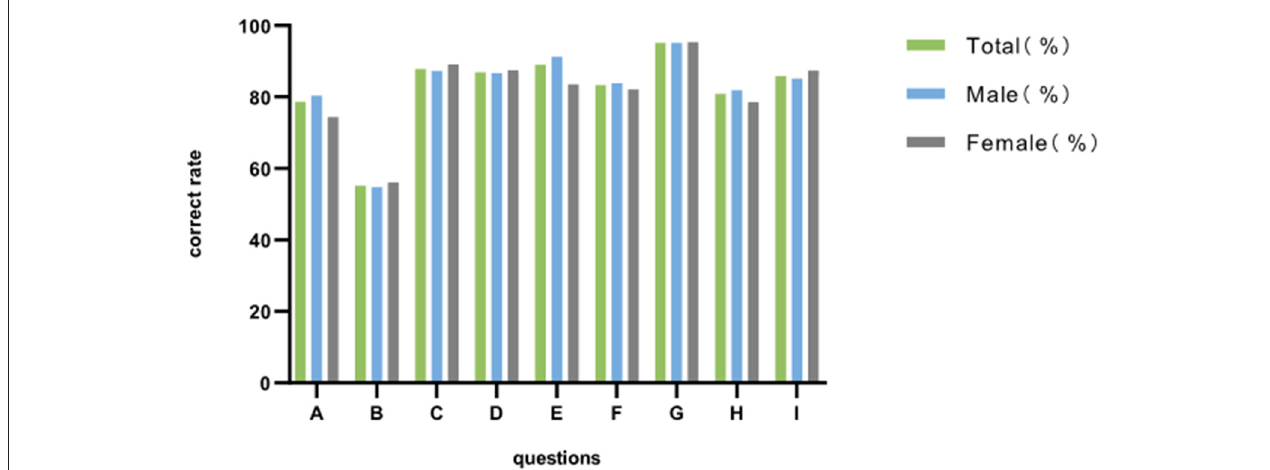
FIGURE 2 | The correct rate of participants’ HIV health education knowledge by gender. (A) AIDS is an incurable disease. (B) The incidence of AIDS among young Chinese students is increasing, and the main mode of.transmission is male homosexual behavior. (C) It can be judged by appearance that a person is infected with AIDS. (D) AIDS may be contracted through daily life and studying. (E) Proper use of condoms can reduce the risk of contracting and spreading AIDS. (F) Drug abuse will increase the risk of contracting AIDS. (G) After a high-risk behavior occurs, we should seek HIV testing and counseling. (H) The rights of HIV-infected people such as marriage/employment/schooling are protected. (I) Sex with acquaintances also need to use condoms.